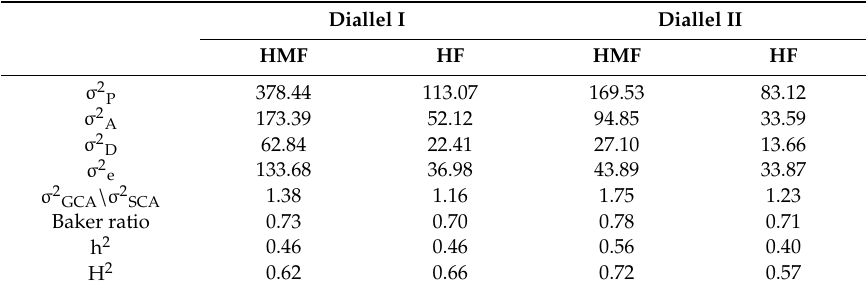
Table 4. Estimates of additive and dominance variances, heritability, and ratios of variances of general and specific combining ability for HMF and HF in two diallel